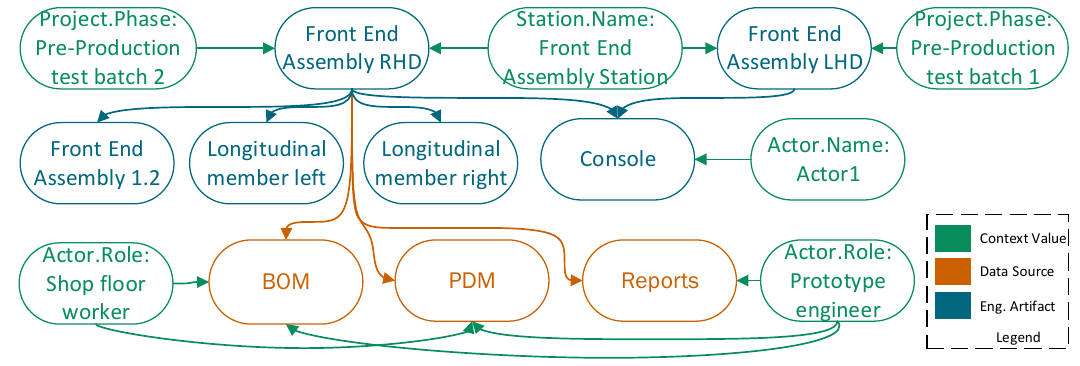
Figure 4. Excerpt of a CAEM instance for the use case